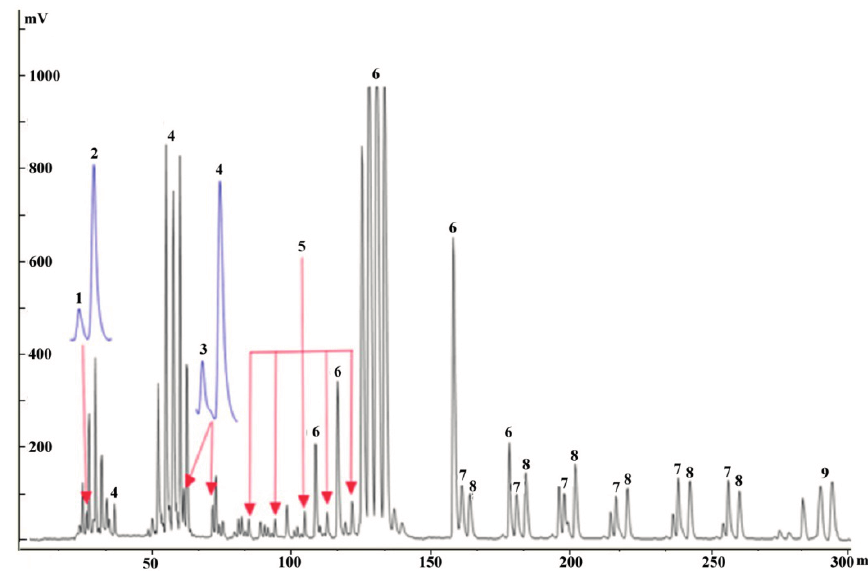
Figure 7. Overall separation chromatograms for the nine compounds on prep-HPLC using the coupled approach, based on offline mode